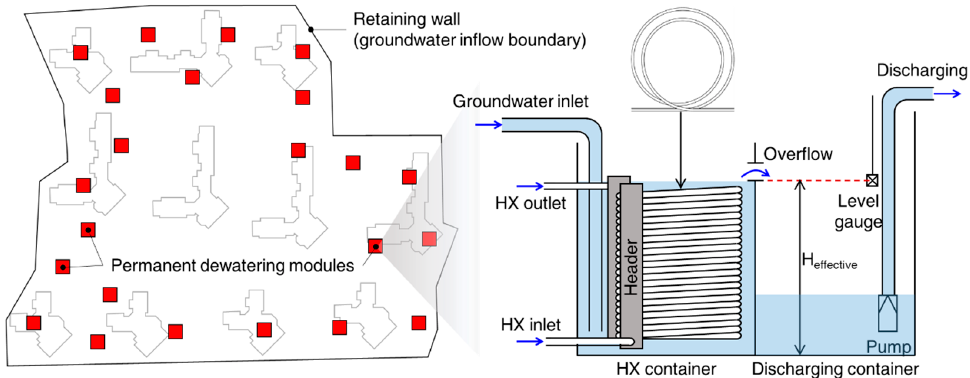
Figure 3. Schematic of the permanent dewatering module (prototype).